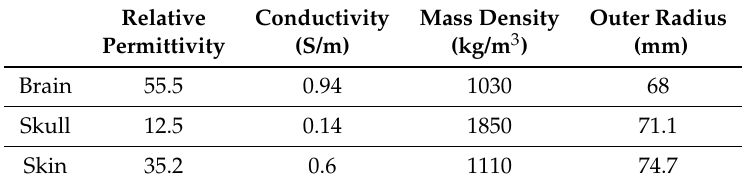
Table 2. Parameters used for the three-layer sphere at 900 MHz (four-year